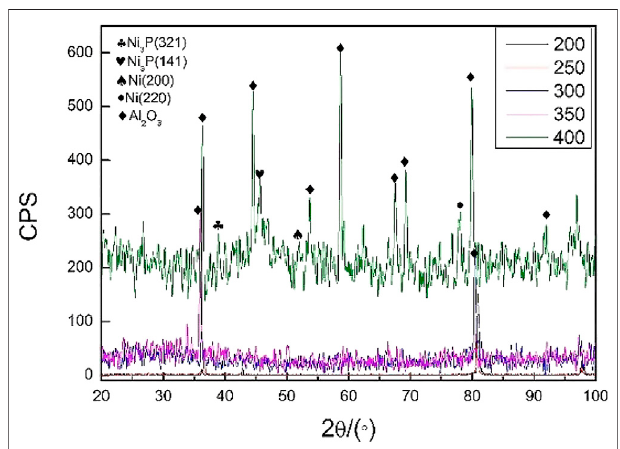
FIGURE 2 | X-ray diffraction analysis